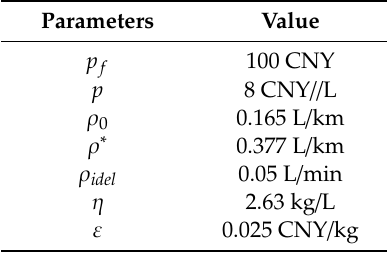
Table 7. Parameters related to the objective